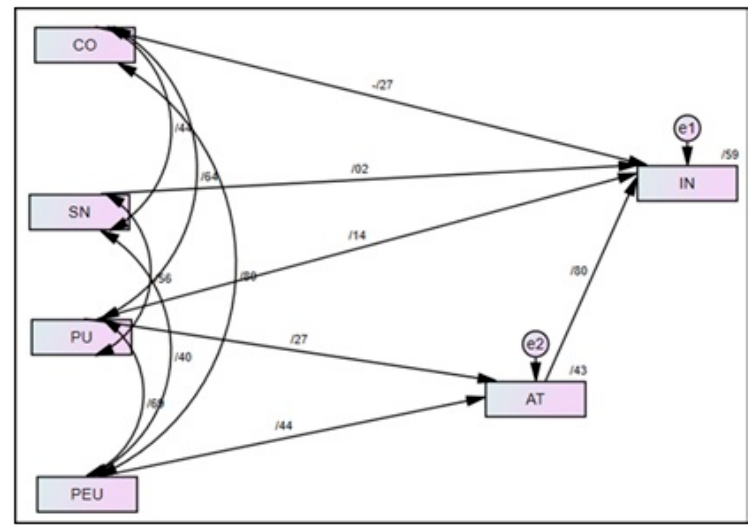
ffi cients in the proposed Figure 6. path coefficients in the proposed model. Figure 6. Path coe